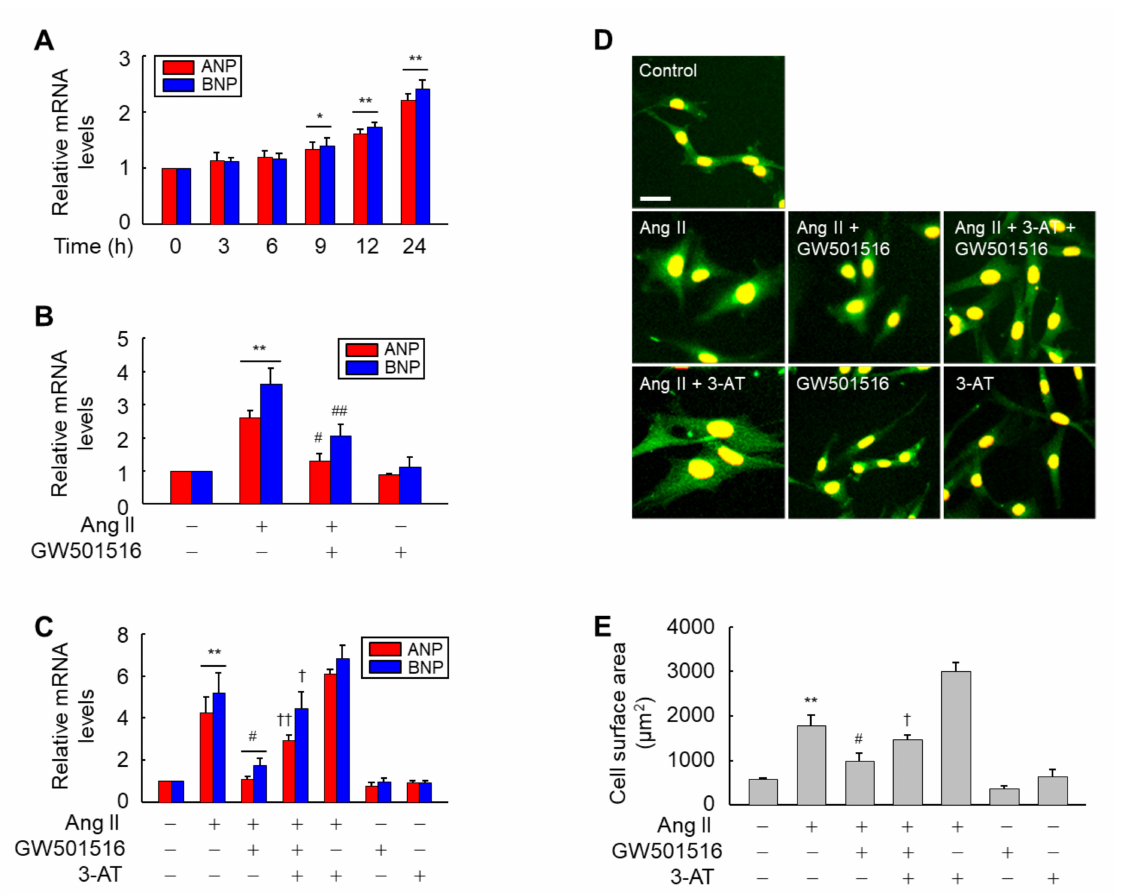
Figure 4. GW501516-activated PPAR δ attenuates the Ang II-induced expression of marker proteins and hypertrophy through catalase in H9c2 cardiomyocytes. ( A ) Cells were incubated with 100 nM GW501516 for the times indicated. ( B ) Cells were pretreated with 100 nM GW501516 for 12 h, and then exposed to 100 nM Ang II for 24 h. ( C – E ) Cells pretreated with 100 nM GW501516 and/or 30 mM 3-amino-1,2,4-triazole (3-AT) for 12 h were treated with 100 nM Ang II for 24 h. The mRNA levels of ANP and BNP were analyzed by real-time PCR ( A – C ). Immunofluorescence assays were performed using α -actinin antibody ( D ) and cell surface area was quantified using an image analyzer and plotted ( E ). Nuclei stained with propidium iodide. Representative images from four independent experiments are shown. Bars = 100 µ m. Results are expressed as mean ± standard error (SE) of 3 to 4 independent experiments (** p < 0.01, * p < 0.05 compared with the untreated group; ## p < 0.01, # p < 0.05 compared with the Ang II-treated group; †† p < 0.01, † p < 0.05 compared with the Ang II plus GW501516-treated